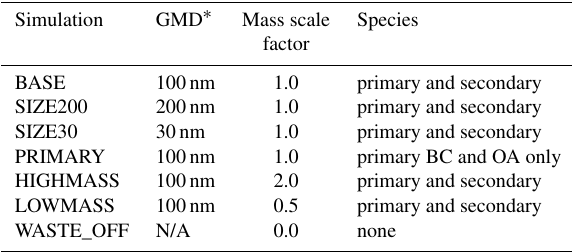
Table 1. Description of simulations.